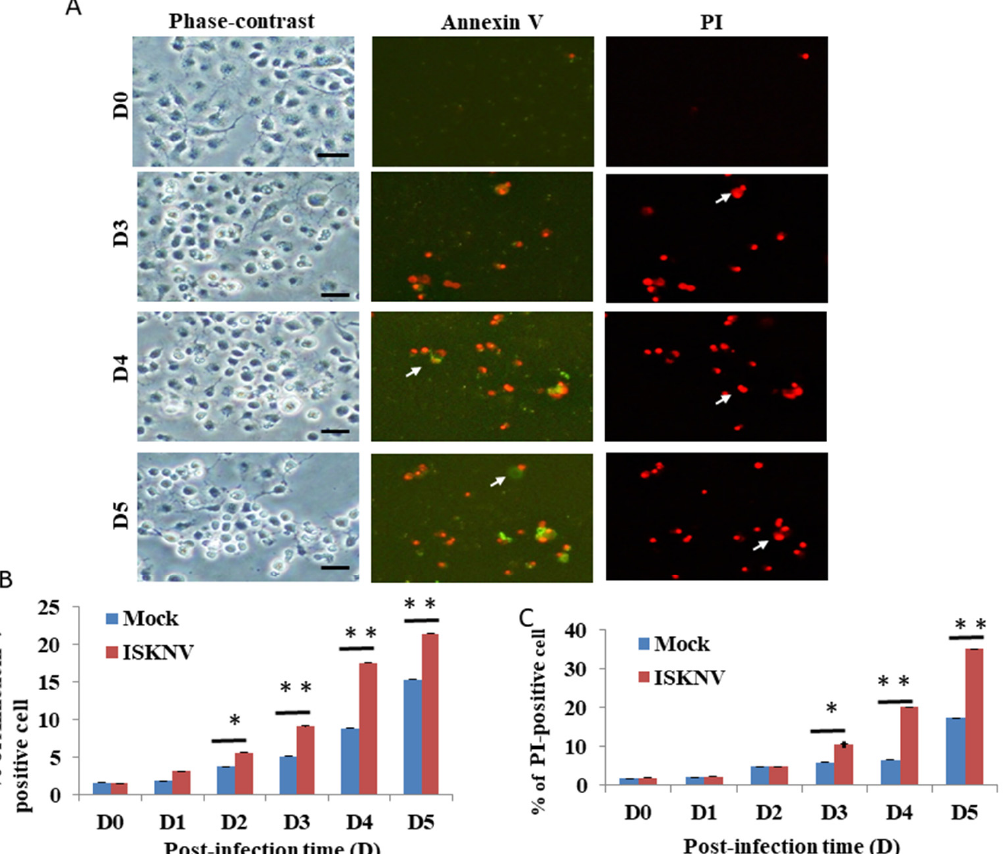
Figure 2. ISKNV directly induces apoptotic/necrosis cell death by dual labeling with Annexin-V/PI staining in GF-1 cells. ( A ) Phase-contrast micrographs of ISKNV-induced apoptotic/necrosis GF-1 cells at different time points (D0, D3, D4, and D5). Phase-contrast (left panels D0, D3 D4, and D5); green fluorescence images for Annexin-V-positive cells (middle panels D0, D3 D4, and D5); and red fluorescence images for necrosis-positive cells (right panels D0, D3 D4, and D5), in which Annexin-V-positive cells and necrosis-positive cells are indicated by arrows. Scale bar=20 µM. ( B , C ) The percentage of